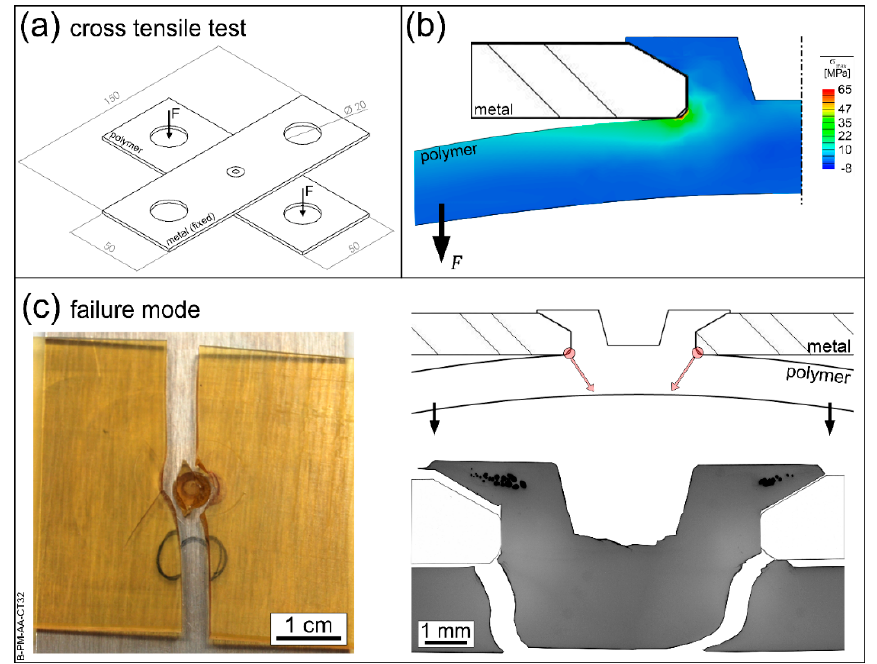
Figure 12. ( a ) Specimen and test configuration for cross tensile testing. ( b ) Stress concentration regions in an F-ICJ joint during cross tensile testing. ( c ) Main failure mode of F-ICJ cross tensile specimens.